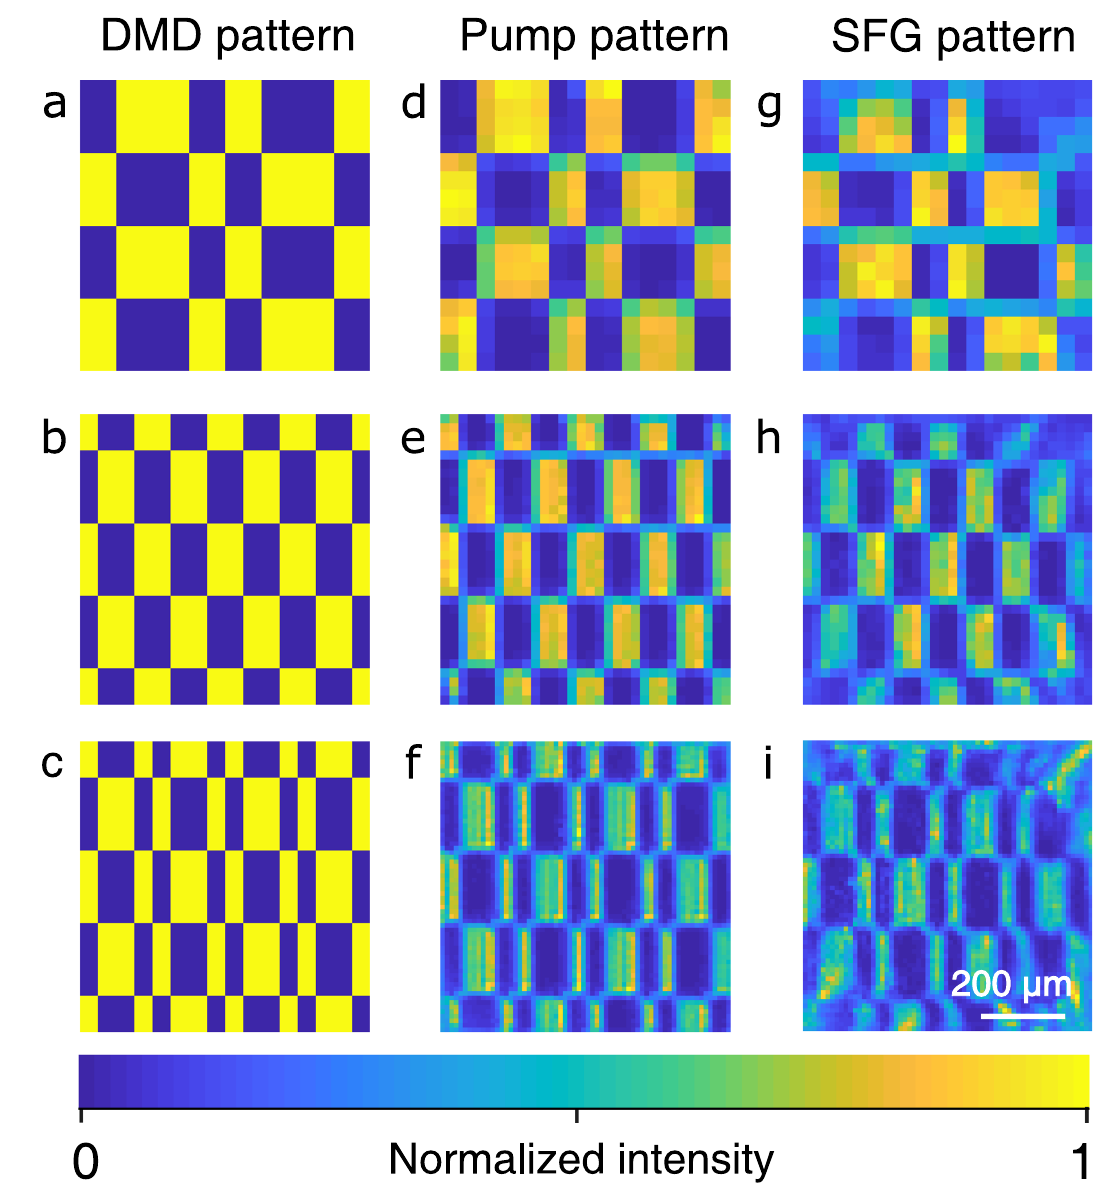
Fig. 2 | Nonlinear structured modulation of optical pump patterns. a – c Exemplary Hadamard patterns written onto the spatial light modulator. d – f Corresponding intensity distributions of the pump at the nonlinear